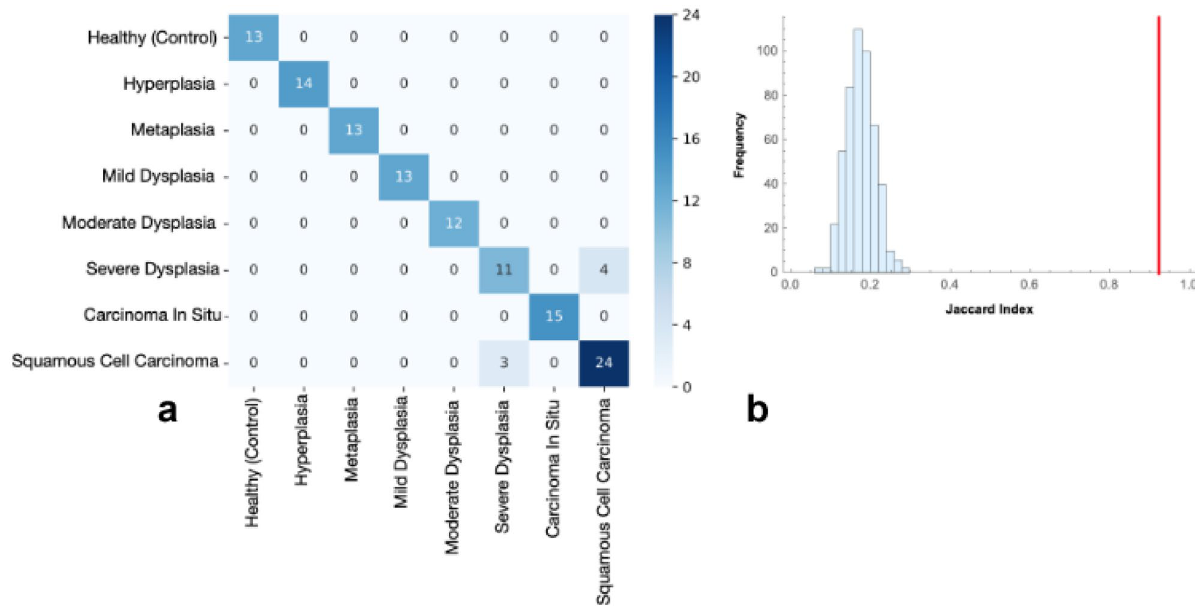
Figure 1. ( a ) Confussion matrix of the model trained with the 15 genes selected using the parameter reduction method. On the x-axis is the true classification and on the y-axis is the predicted classification for each of the 122 patient records. ( b ) Histogram of the Jaccard indexes from 500 trained models with random sets of 15 genes; In red the Jaccard index of the trained model with the 15 genes selected using the parameter reduction method. Figures were made using the library matplotlib of